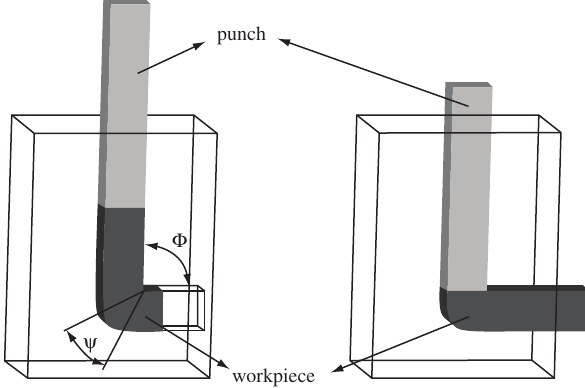
Figure 1. Illustration of the ECAP die geometry.